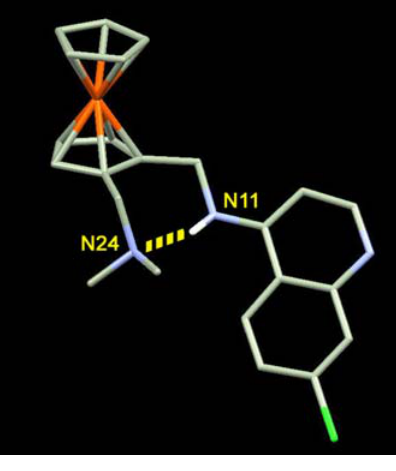
Figure 3. Intramolecular hydrogen-bond in neutral